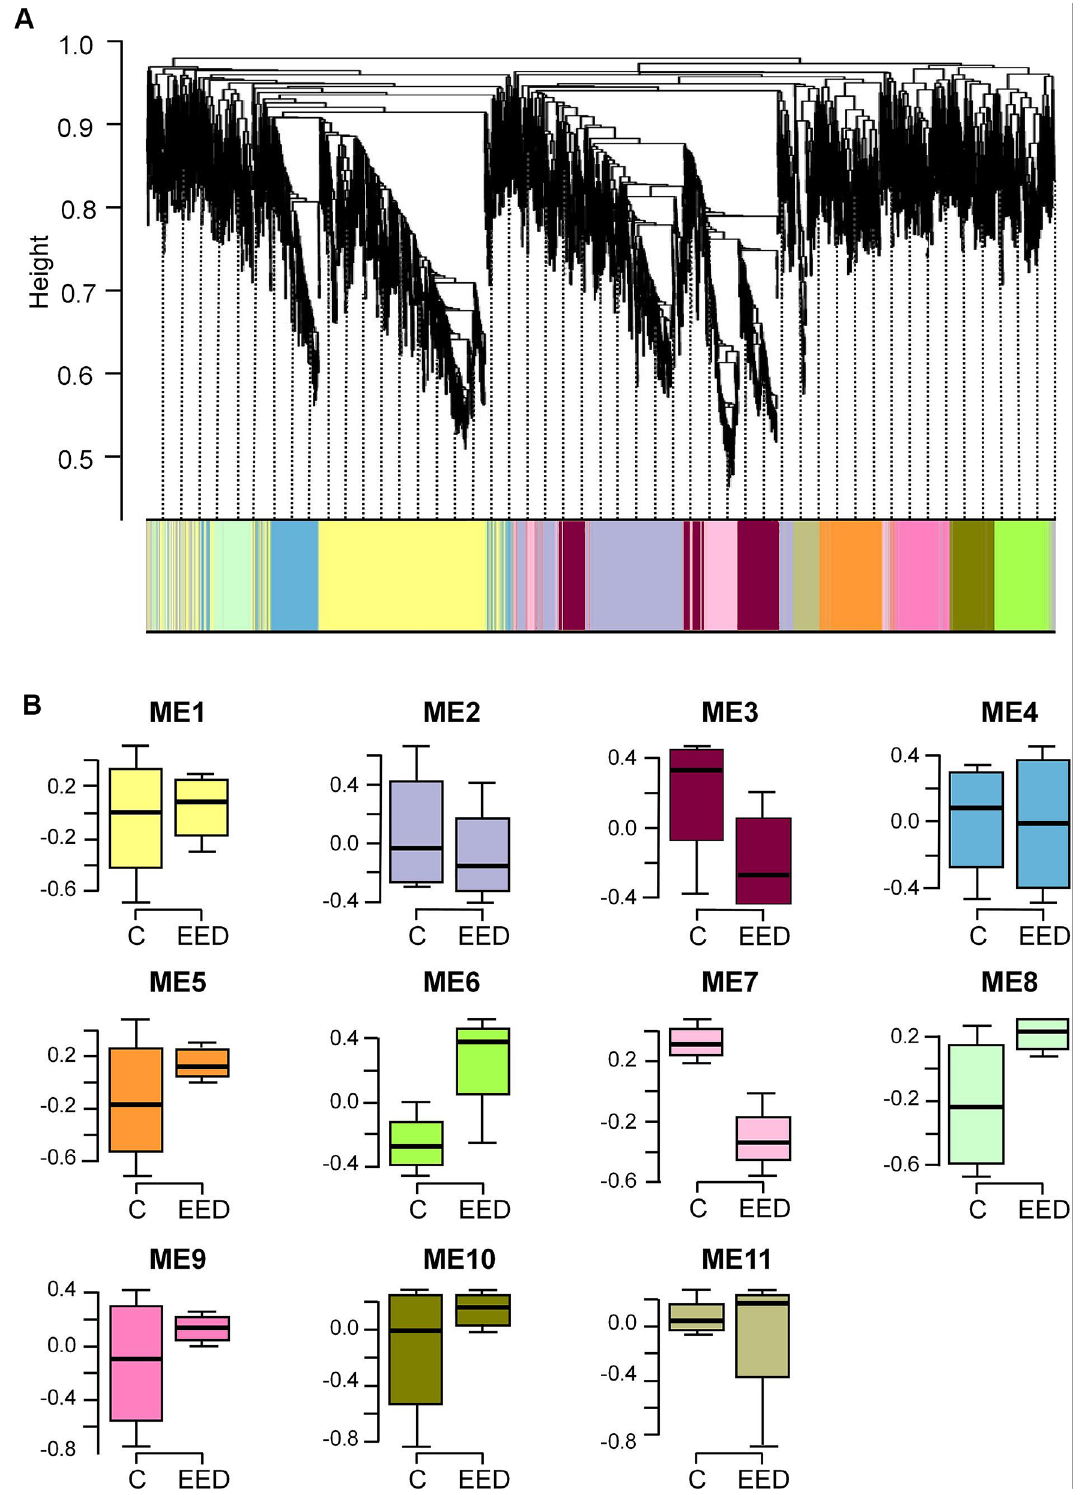
Figure 1. WGCNA analysis of gene expression after EED overexpression targeted to the ARC of prepubertal female rats. ( A ) Dendrogram of WGCNA module memberships of the top 5000 most variable genes detected by RNA-seq in the MBH of prepubertal female rats overexpressing EED in the ARC region of the MBH. The different colors depict the 11 identified modules. ( B ) Boxplots of module eigengene values for control (( C ), LV-GFP-injected animals) and EED-overexpressing (EED, LV-EED-injected animals) groups (excluding module zero). Boxplot colors map to the dendrogram shown in ( A